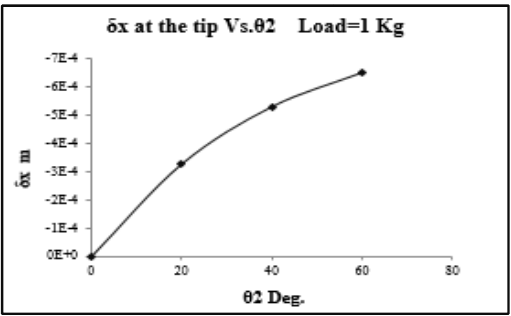
Fig. 11. δ x Vs. θ 2 Deg.